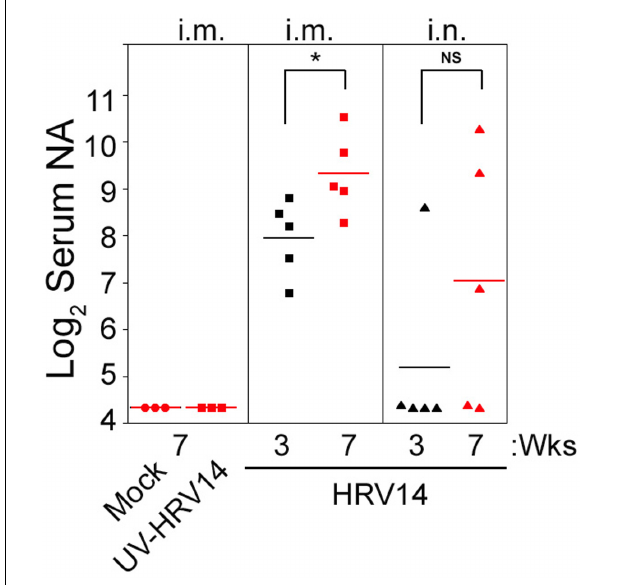
FIGURE 2 | Profile of serum NA in i.m. immunized or i.n. infected cotton rats using HRV14. Female cotton rats were mock-immunized or i.m. immunized with 10 6 PFU/100 µ l of UV-HRV14 or HRV14 on day 0 and boosted 3 weeks after the first immunization. Another group of rats were i.n. infected 10 6 PFU/100 µ l of HRV14 on day 0 and re-infected at 3 weeks. Serum samples were obtained on the 3rd (black symbols) and 7th week (red symbols) after the first immunization or infection and homologous serum NA against HRV14 were analyzed. The sera were assayed in duplicate and NA titer is expressed as Log 2 geometric mean ± SEM of the reciprocal dilution of serum samples that achieved 60% reduction of the total plaques. ∗ p < 0.05 in Student t- test comparison between 3 weeks vs. 7 weeks i.m. immunized or i.n. infected groups. n = 3–5 per